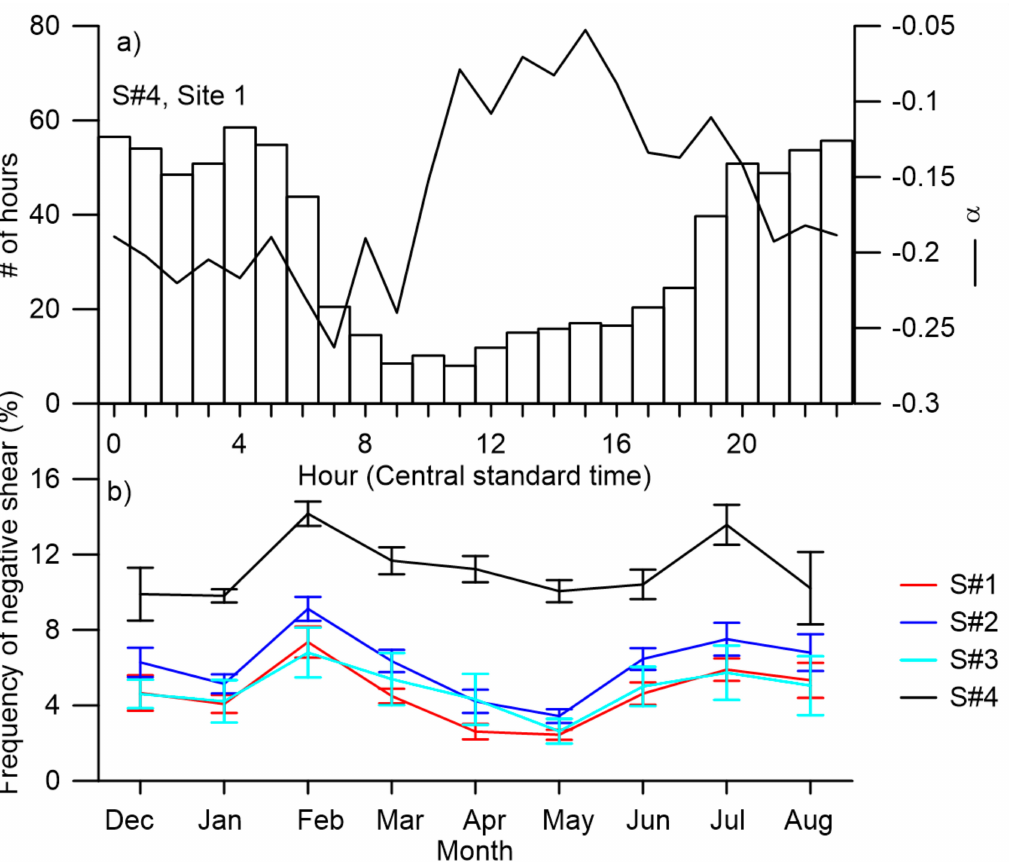
Figure 10. Negative shear: ( a ) The diurnal frequency (number of hours) and shear exponent α for negative shear hours at S#4, Site 1 (43 ◦ N, 95 ◦ W). ( b ) Mean frequency of negative shear for the four sites and for four scenarios (shown by the color